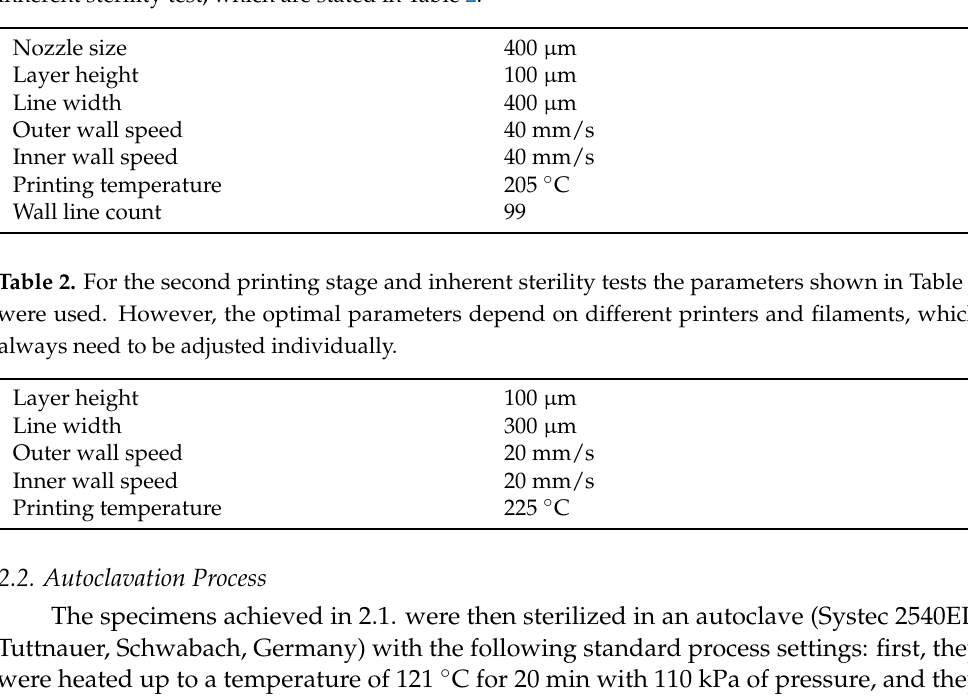
Table 1. For the printing of the specimens, the following parameters were used. It shows the global standard settings used for most printed parts of this study, except the second printing stage of the inherent sterility test, which are stated in Table 2.